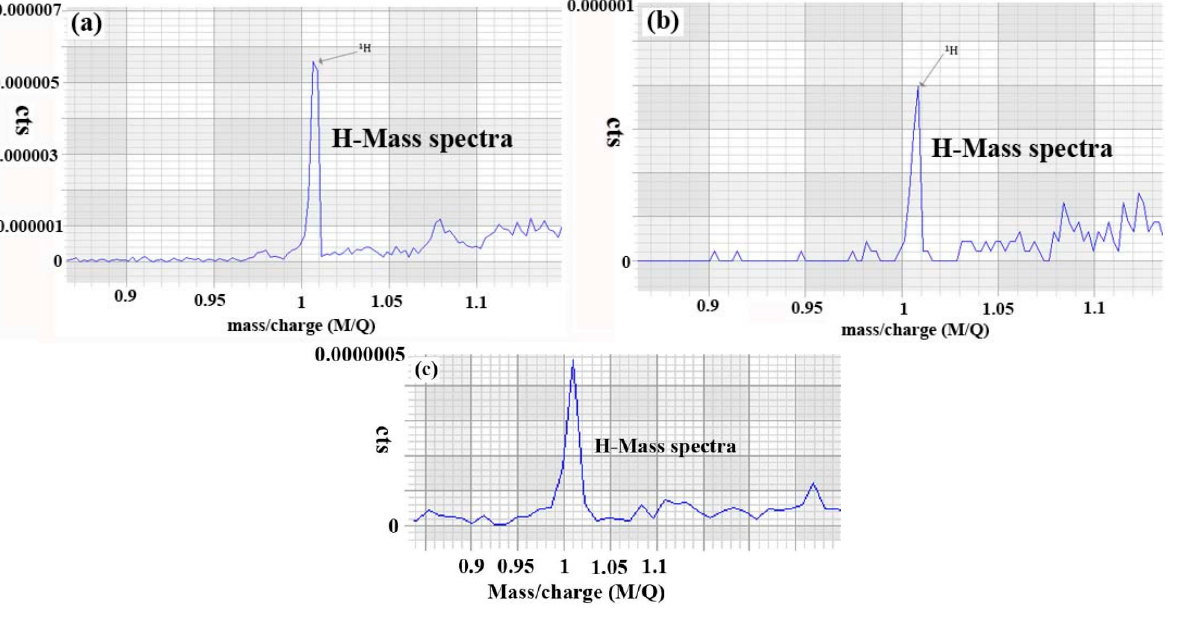
Figure 6. The integrated area of H peak: ( a ) Near the fracture ( b ) Far from the fracture in simulated working condition, ( c ) In atmosphere.